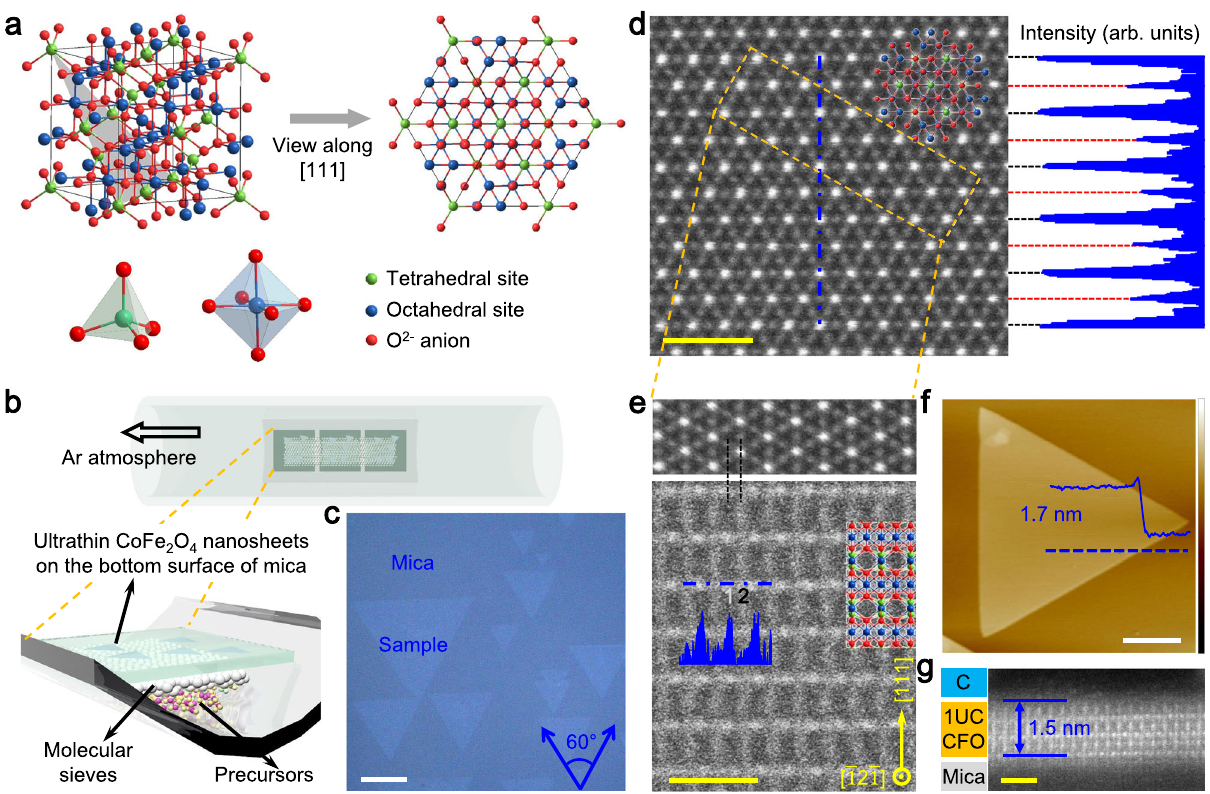
Fig. 1 | Van der Waals epitaxial growth of ultrathin CFO nanosheets. a The atomicmodelofCFOwithspinelstructureanditstopviewalongthe[111]zoneaxis. b Schematic illustration of epitaxial CFO nanosheets on mica substrate. c Optical microscopy image of the ultrathin triangular CFO nanosheets with a strong (111) orientationgrown byvanderWaalsepitaxy.The imagecontrastis strengthenedto improve its visibility. Scale bar: 10 μ m. d Plan-view HAADF-STEM image of